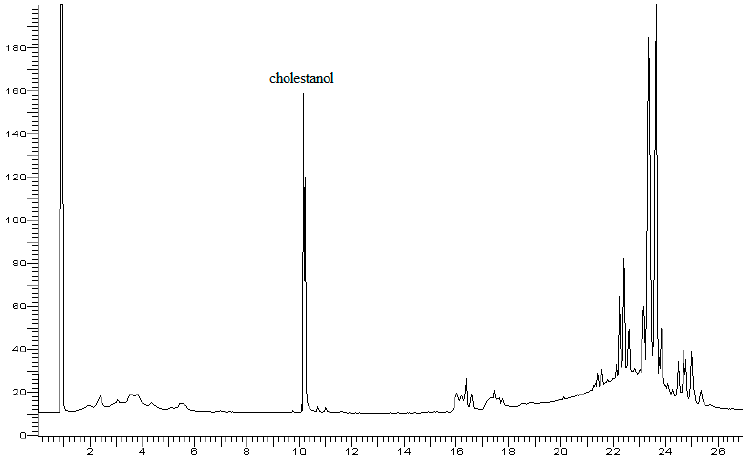
Figure 4. Gas chromatogram of fat extracted from egg yolk with addition of cholestanol as an internal standard (IS). Carrier flow: 2.0 mL/min.